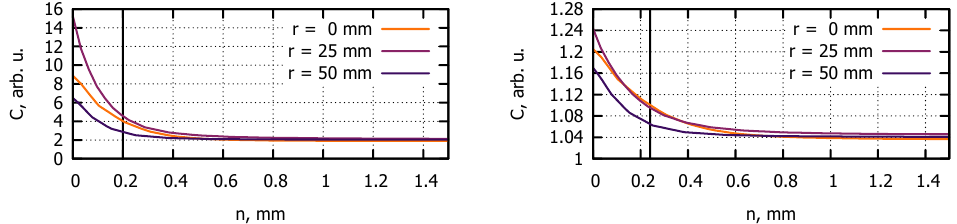
Figure 13. The distribution of carbon ( left ) and boron ( right ) concentration in the melt, near the crystallization interface ( D C = 102mm). The normal coordinate is denoted by n , and different radial positions r are considered. Boundary layer thicknesses from the BPS model (1) are shown with vertical black